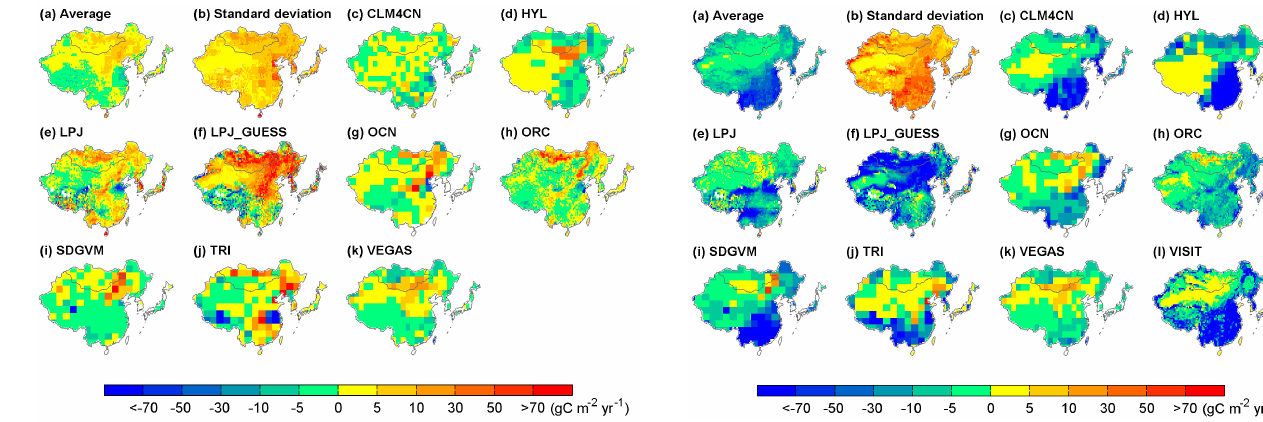
Fig. 4. Nine ecosystem models simulated spatial patterns of net ecosystem carbon balance attributed to climate change (obtained from the difference between simulation S2 and S1) during the pe- riod 1990–2009. (a) Average net ecosystem carbon balance from the nine models, (b) standard deviation of the nine model-derived net ecosystem carbon balance, and (c – h) net ecosystem carbon bal- ance estimated by each model. Negative value indicates net carbon sink.